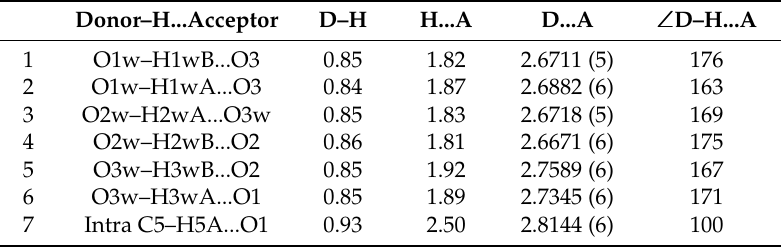
Table 2. Lengths (Å) and angles (°) of hydrogen bonds data for 1 .